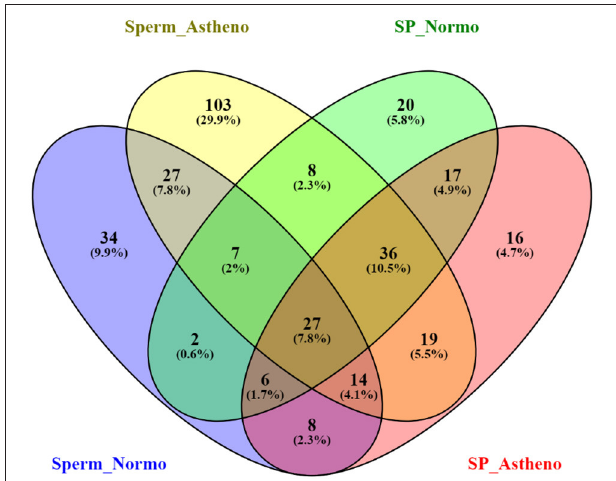
FIGURE 1 | Venn diagram of total mapped metabolites of spermatozoa and seminal plasma of astheno-oligozoospermia and normozoospermia bulls in HMDB